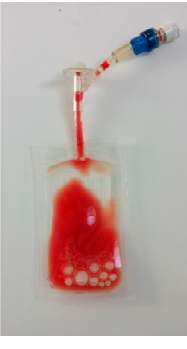
Figure 1. Final L-PRP bag ready for clinical use.